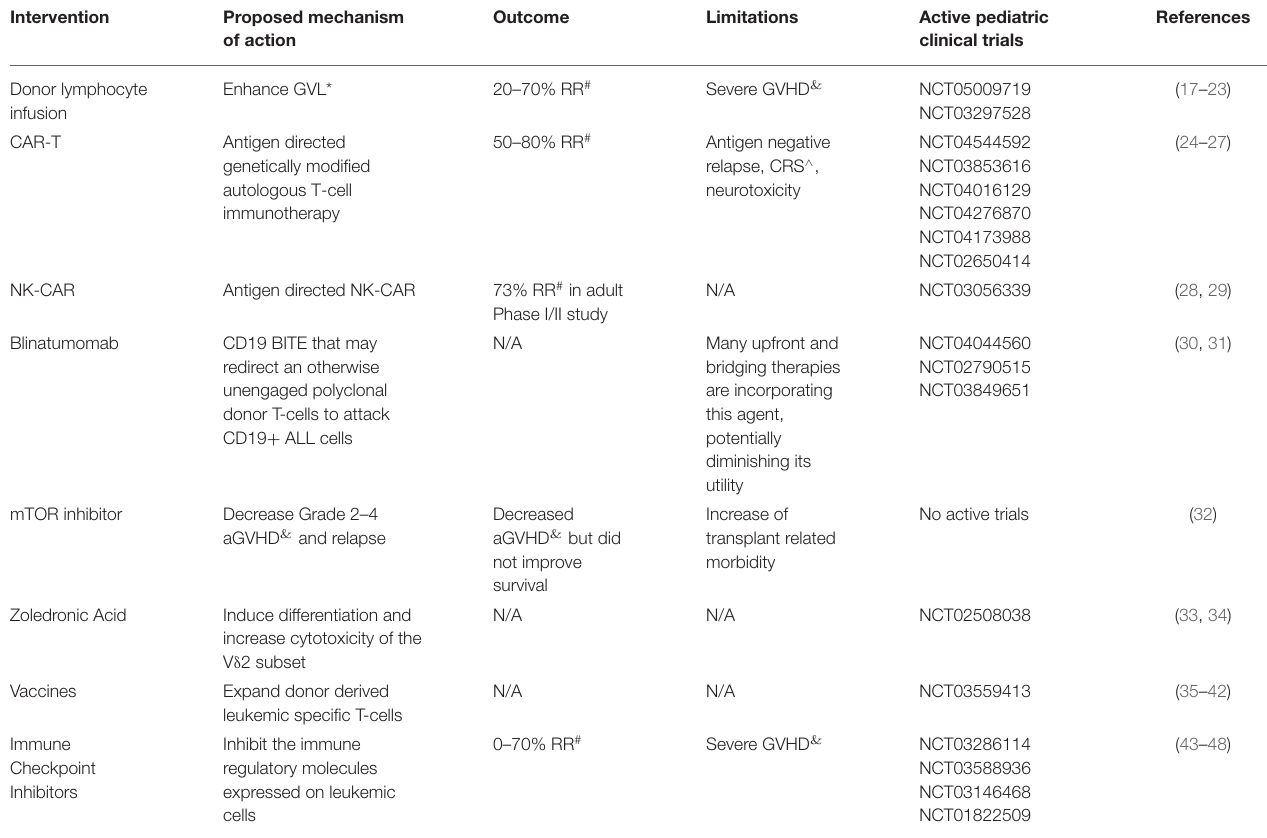
TABLE 1 | Cellular and pharmacologic approaches to modify graft vs. leukemia effect post-HCT for